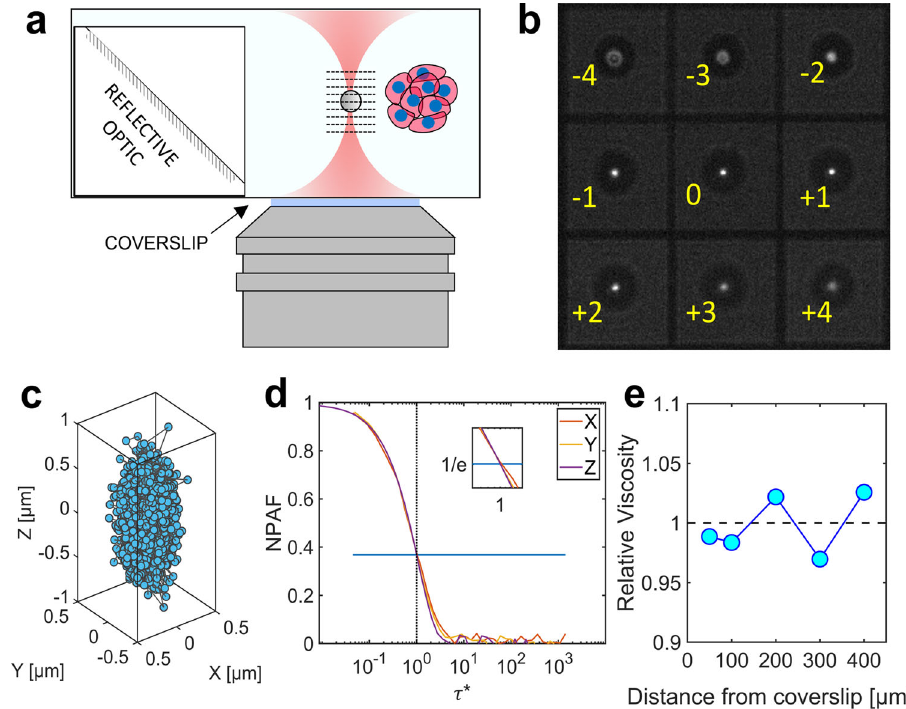
Fig. 4 Microrheology with an optical trap and multiplane detection. 3D particle tracking mode in an aqueous solution. a An optically trapped microsphere is imaged in 9 planes simultaneously (planes represented by dashed lines). b Captured image of nine separate Z planes ( Δ z = 0.79 μ m). The planes (labelled from number − 4 to + 4) are simultaneously recorded at the camera sensor to extract the 3D trajectory. c The resulting 3D trajectory of optically trapped microsphere in water with individual positions depicted as blue circles (down sampled for clarity from a total of 2 × 10 5 frames). d The normalised position autocorrelation function (NPAF) versus dimensionless time τ ? provides the relative viscosity (dotted line) ‘ at a glance ’ . e The relative viscosity measured at each position over a range of